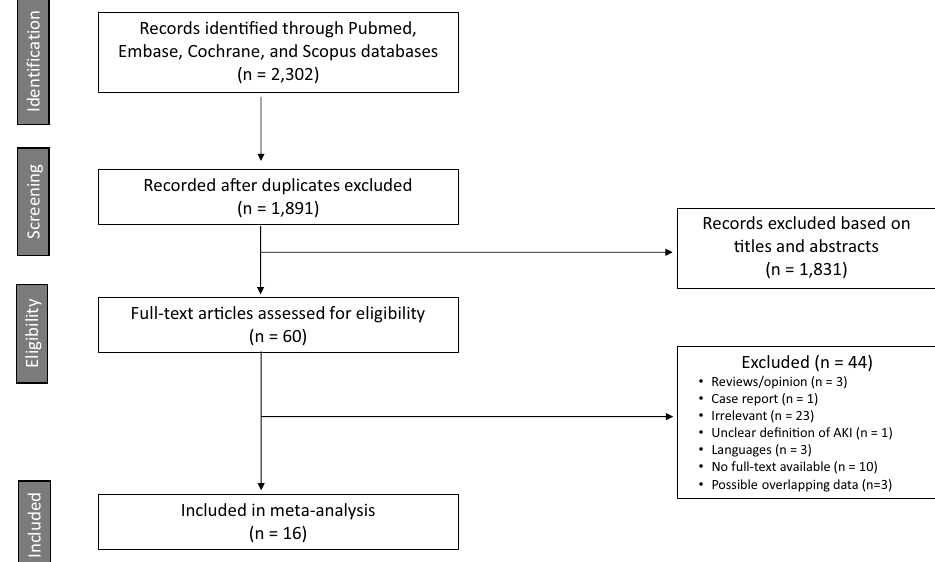
Figure 1. Flow diagram of the study